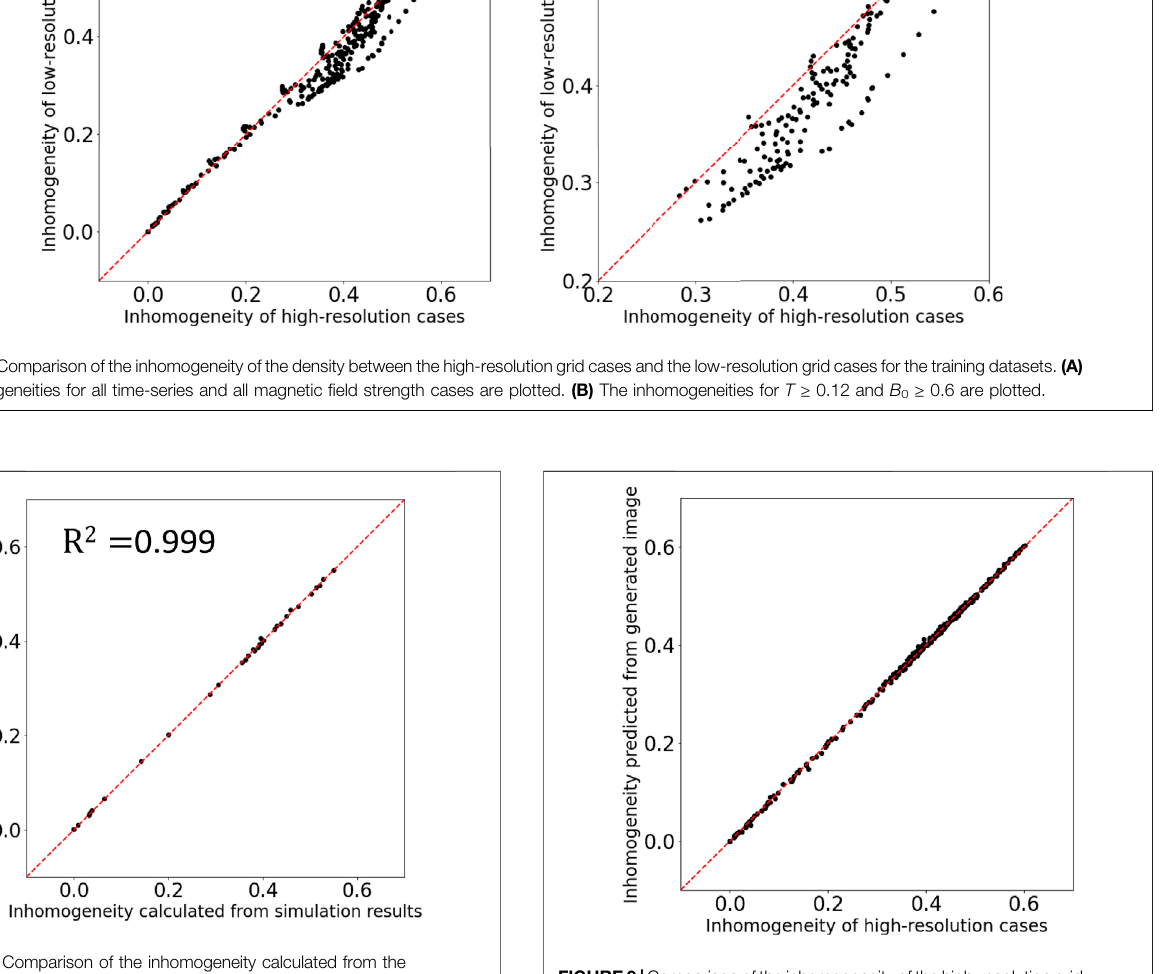
FIGURE9| Comparisonoftheinhomogeneityofthehigh-resolutiongrid simulationresultsandtheinhomogeneitypredictedfrom thesynthesisimages for the training